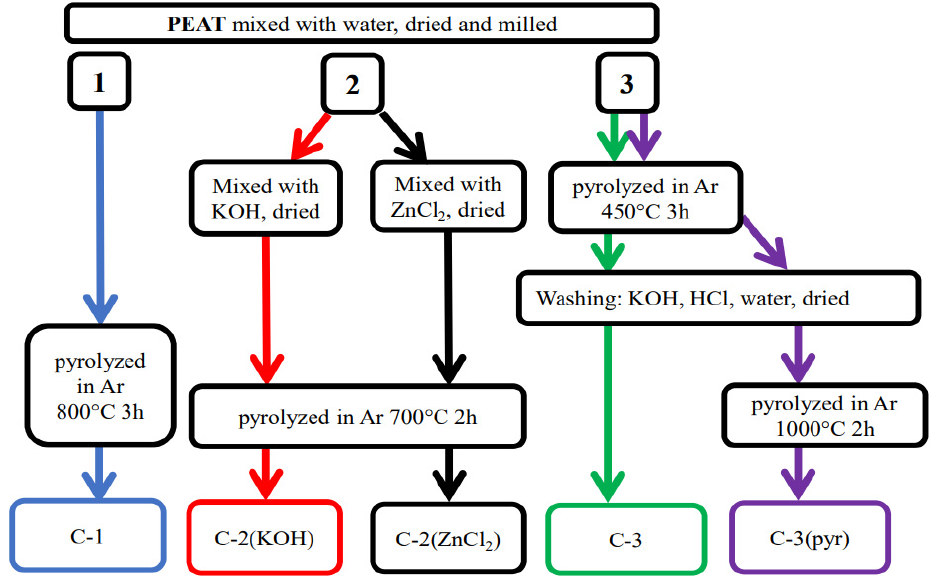
Figure 1. Synthesis steps and abbreviations of prepared carbons.